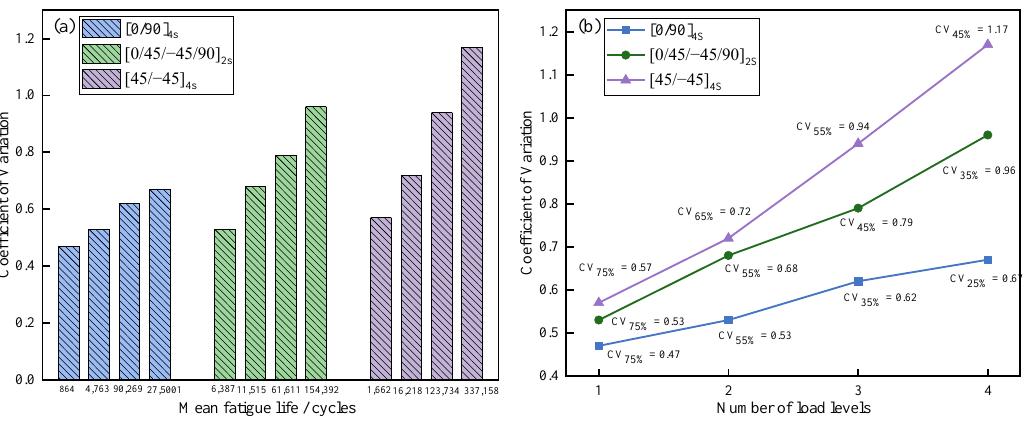
Figure 6. Variations of the CV of the joints: ( a )The relationship between MTTF and the CV, ( b )The relationship between load level and the CV